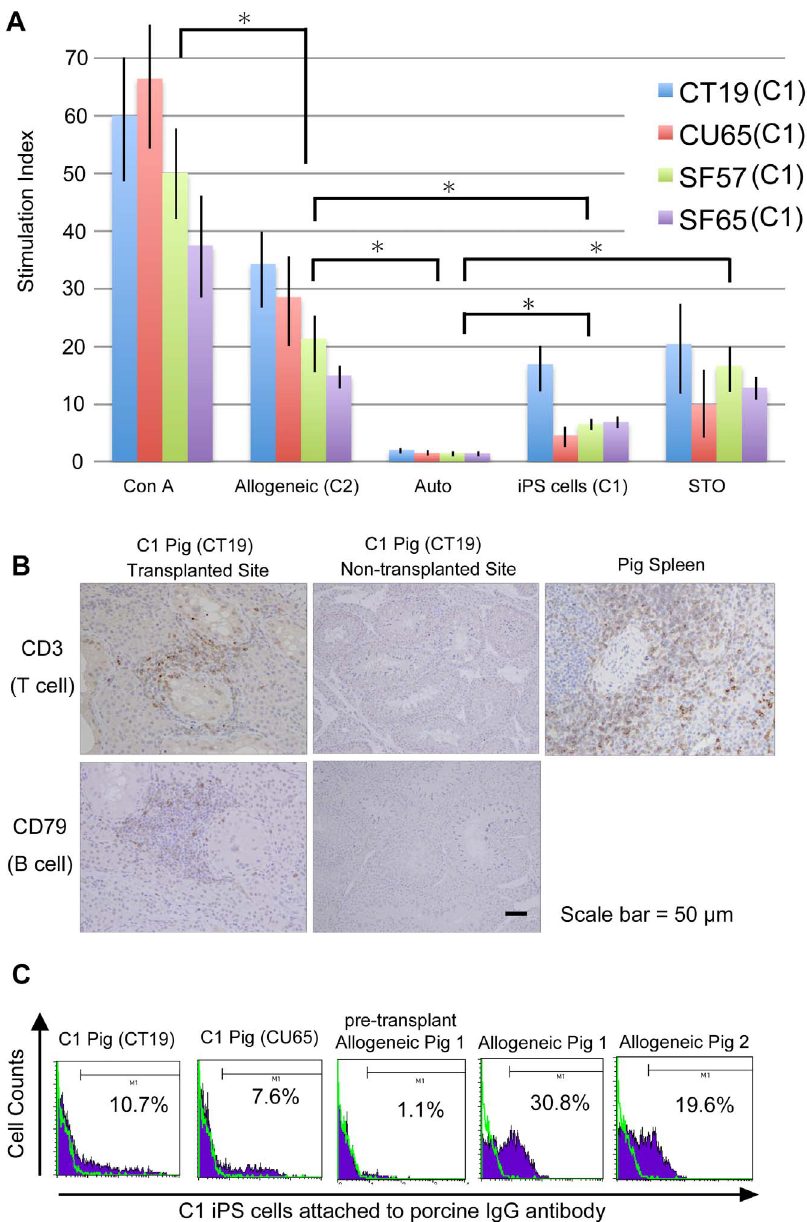
Figure 1. Cellular and humoral immune responses in an SLA-matched setting. (A) Mixed lymphocyte reactions (MLRs) against allogeneic (C2) porcine embryonic fibroblasts (PEFs), C1 iPS cells and STO feeder cells. Peripheral blood mononuclear cells (PBMCs) supplemented with concanavalin A (Con A) and C2 PEFs were used as positive controls, and autologous PBMCs (C1) were used as a negative control. The stimulation index of C1 iPS cells was significantly lower than that of allogeneic cells ( * p , 0.01), but significantly higher than that of autologous cells ( * p , 0.01). MLR was performed in triplicate and repeated three times and a typical result was shown. (B) Immunohistochemical staining with anti-CD3 and anti- CD79 antibodies. Pig spleen was stained with the anti-CD3 antibody as a positive control. Slight infiltration of CD3 + T-cells and CD79 + B cells was detected at the transplantation site in the SLA-matched pig CT19. (C) Porcine IgG antibodies against C1 iPS cells were determined by flow cytometry. As SLA-mismatched recipients, miniature pigs that were not C1 or C2 were used. The porcine IgG against C1 iPS cells was detected at much lower levels in the SLA-matched C1 pigs (CT19 and CU65) than in the SLA-mismatched allogeneic pigs. Cells labeled with secondary antibody without porcine serum as a negative control. cytotoxicity of C1 iPS cells to NK cells was assessed by lactate Cell Sorter SH800 (SONY, Tokyo, Japan), the fraction of CD3- dehydrogenase (LDH) release assay. Percent cytotoxicity was negative and CD16-positive cells was collected. The collected cells calculated as follows: cytotoxicity (%) =(Experimental value – were used as porcine NK cells. C1 iPS cells were incubated as Effector control – Target control) 6 100/(High control – Target target cells with NK cells at ratios of 1:30 for 6 h at 38.5 u C in control). The High control was obtained after incubating C1 iPS DMEM supplemented with 1% FBS, 0.1 mM 2-mercaptoethanol cells with 2% Triton X-100. The Effector control and the Target and 1 ng/ml recombinant porcine IL-2 (R&D systems). The